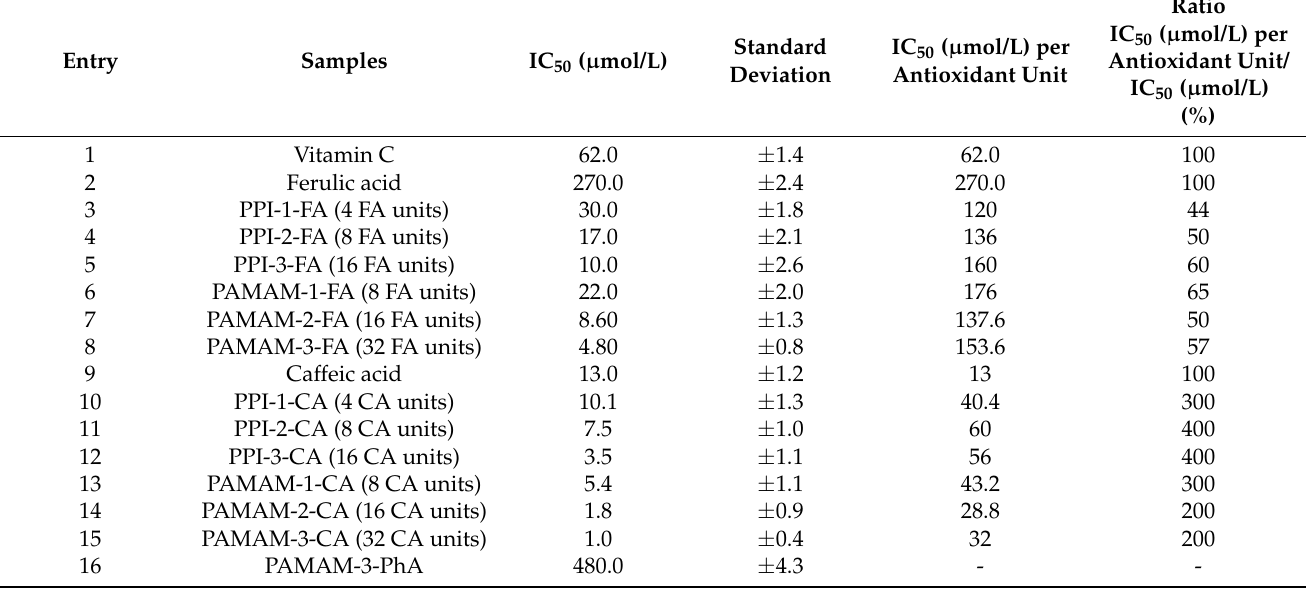
Table 4. Antioxidant activity of ionic dendrimers, determined as IC 50